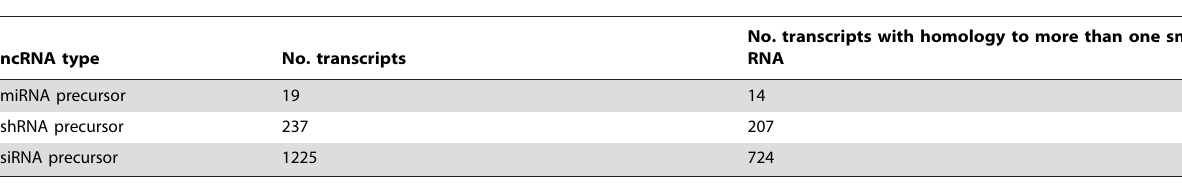
Table 3. ncRNAs with homology to multiple small